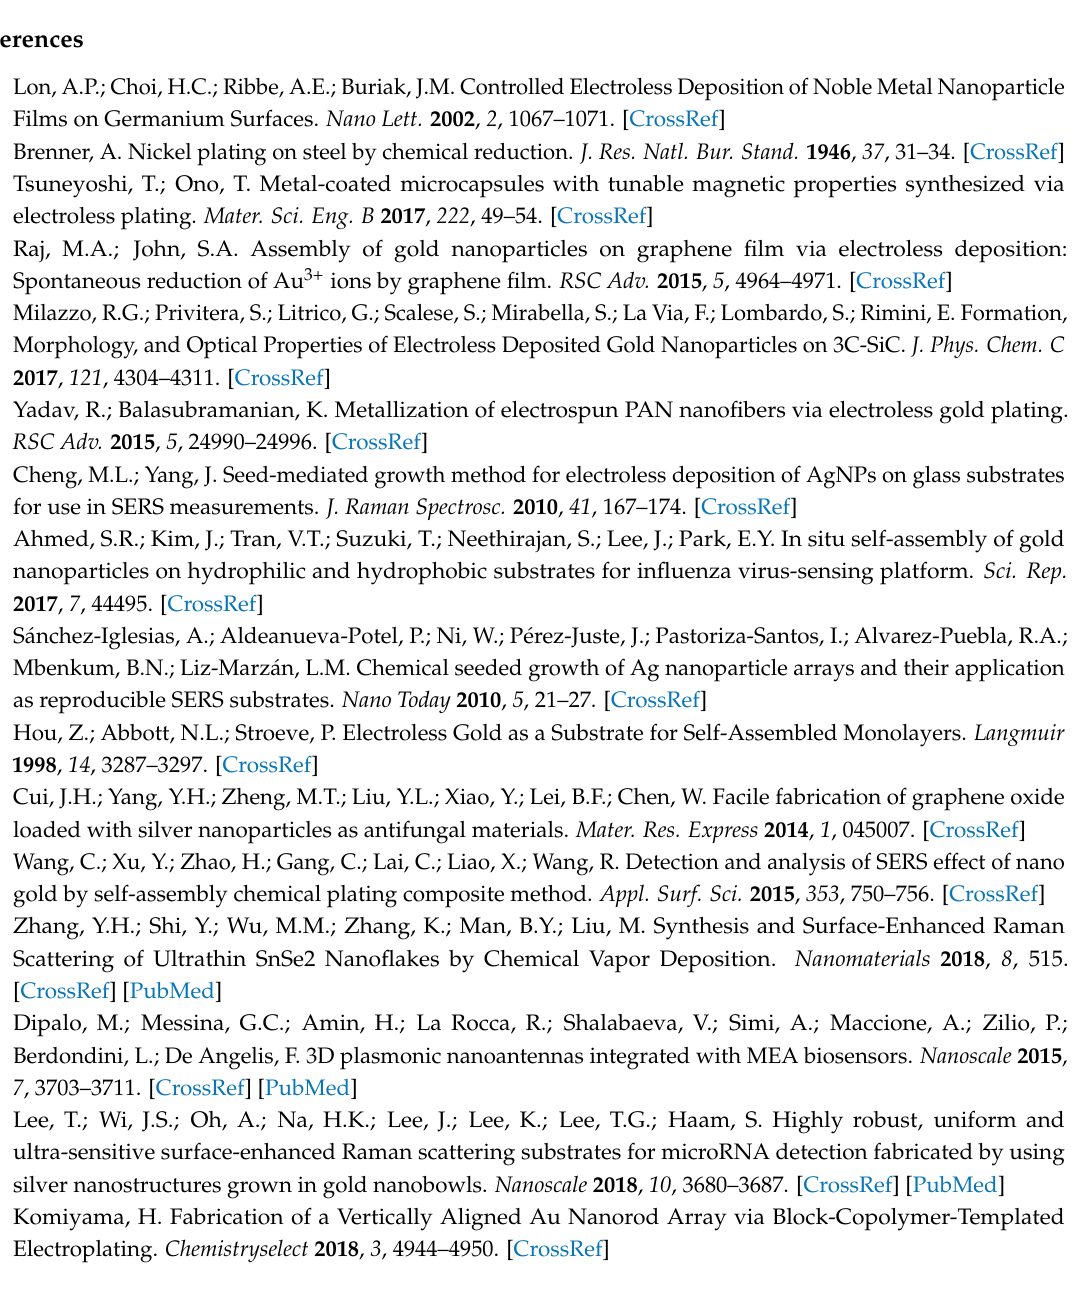
Figure S1: UV-Vis spectra of Au seed solutions, Figure S2: UV-Vis spectra of Au nanoparticle films, Figure S3: SERS performance of Au nanoparticle films formed by seed I activation and with 2 h of immersion, Table S1: Relative standard deviation of the major peaks of the SERS